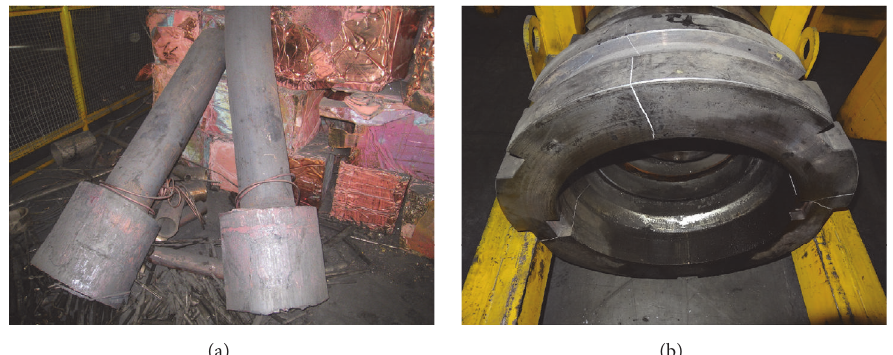
Figure 1: Defect of large diameter cupronickel alloy pipes during hot extrusion: (a) overload; (b) die crack.